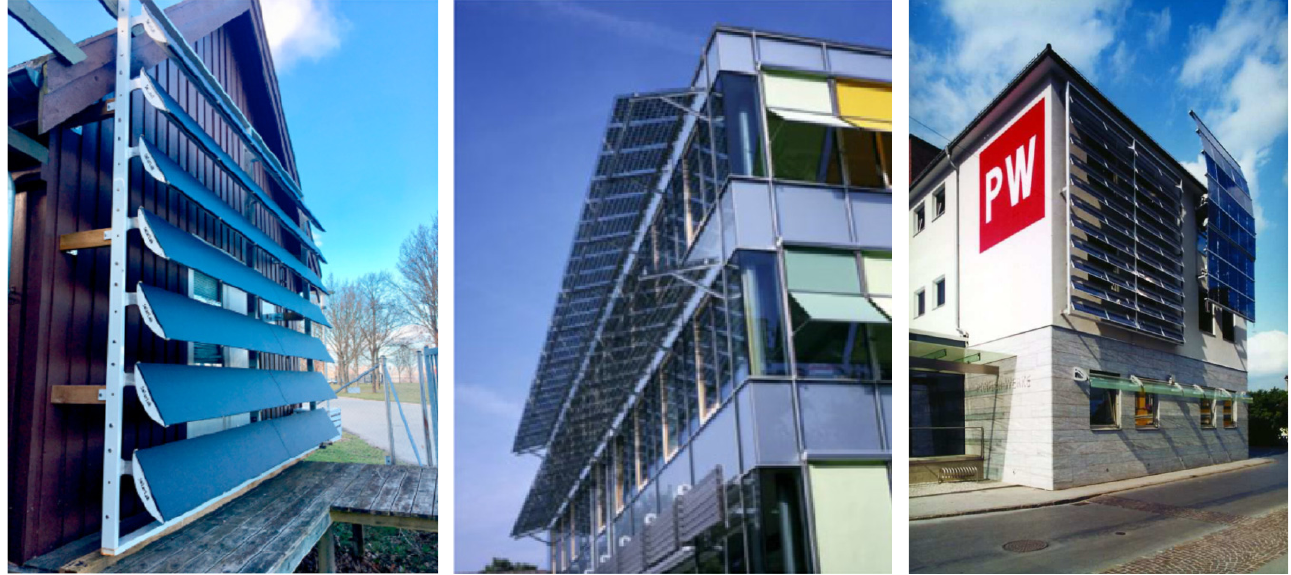
Figure 4. Cases of different PVSDs [19,31,32].